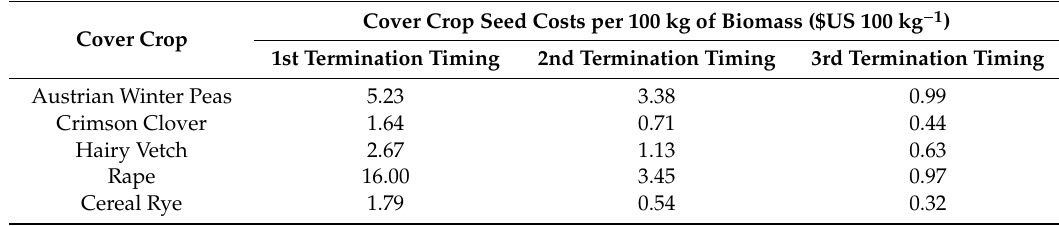
Table 5. Cover crop seed costs per 100 kg of biomass averaged over 2014–2015.